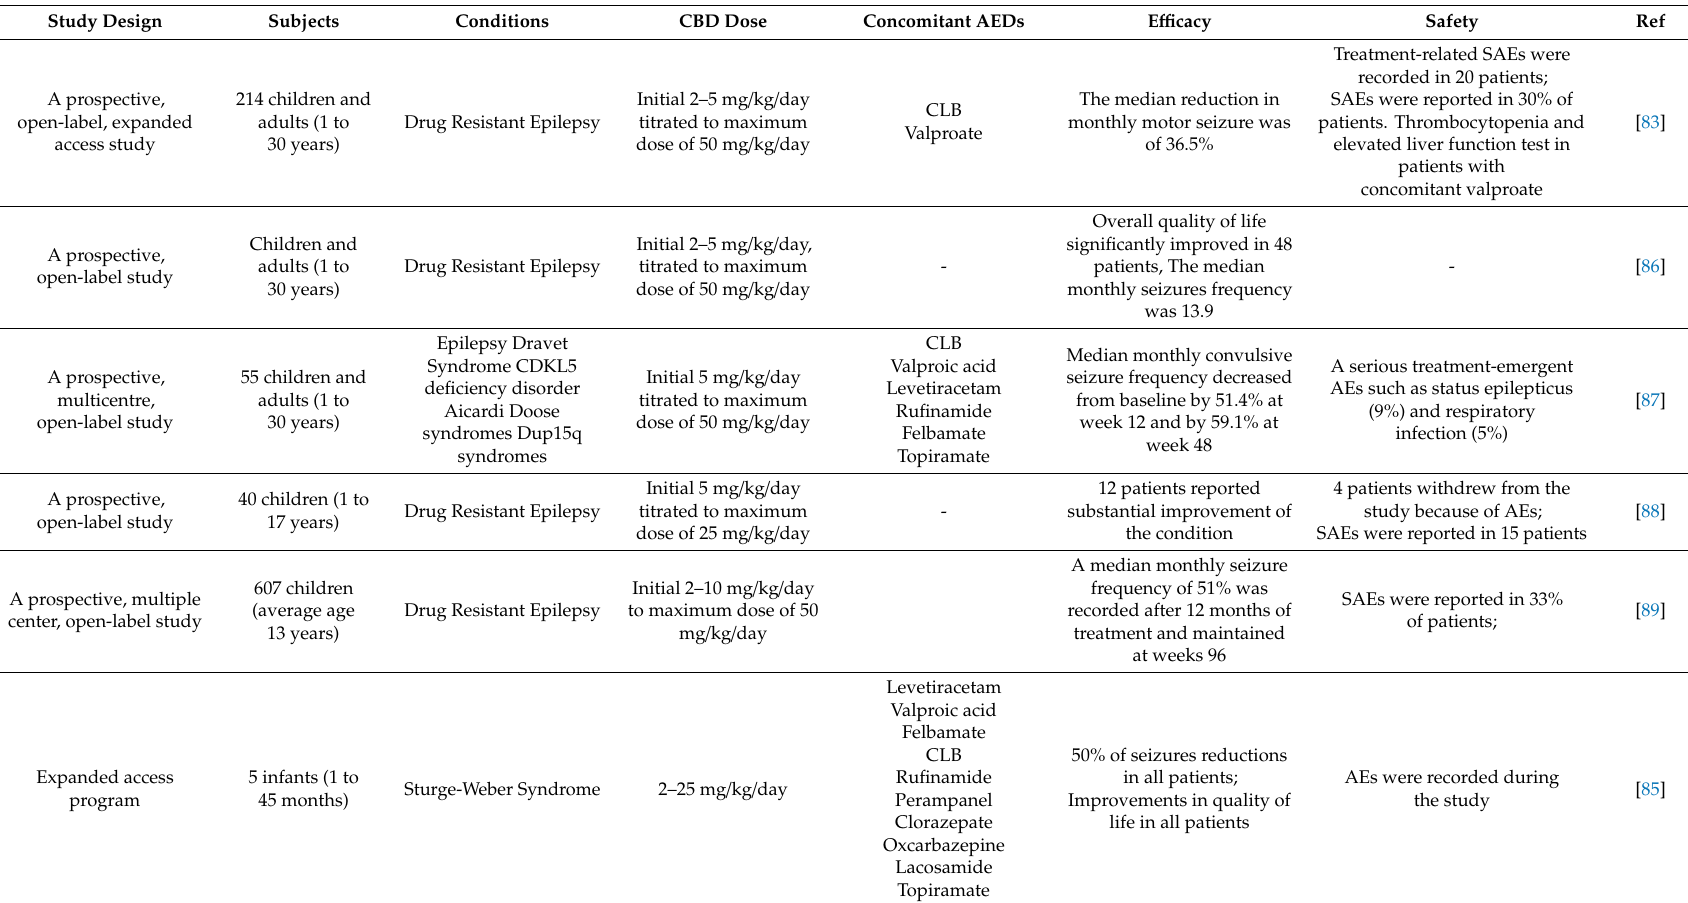
Table 2. Data obtained from trials authorized by local ethics committees (https: // www.ncbi.nlm.nih.gov / pubmed / ). The table shows the e ffi cacy and safety of CBD in di ff erent forms of epilepsy. In all studies, CBD is used as adjunctive therapy to conventional antiepileptic